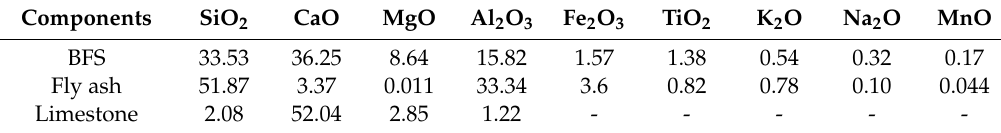
Table 1. The components of blast furnace slag (BFS) and modifying agent (mass fraction / %). Components